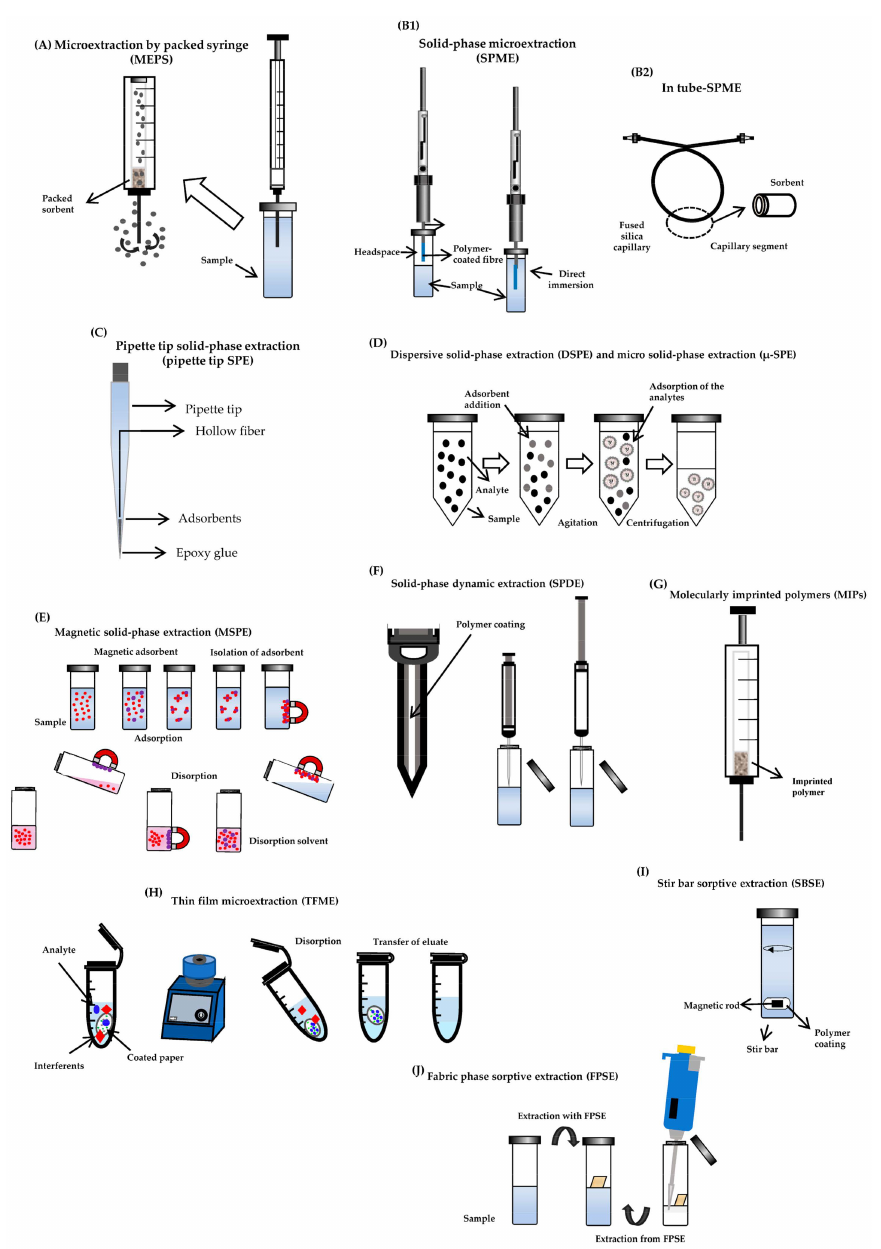
Figure 1. Solid phase-based microextraction approaches for sample preparation: ( A ) MEPS; ( B1 ) SPME and ( B2 ) in-tube SPME; ( C ) pipette tip SPE; ( D ) DSPE and µ -SPE ( E ) MSPE; ( F ) SPDE; ( G ) MIPs; ( H ) TFME; ( I ) SBSE and ( J )